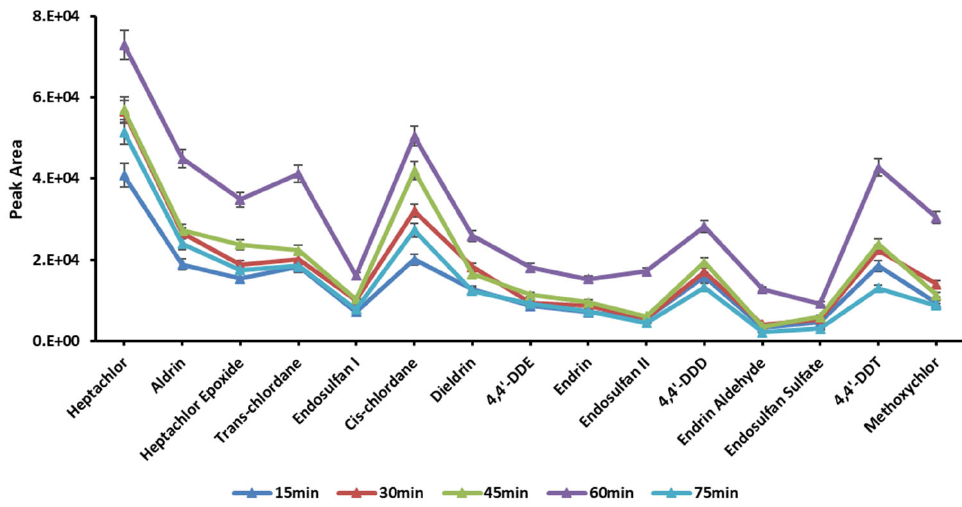
Figure 6. Optimization of extraction time.